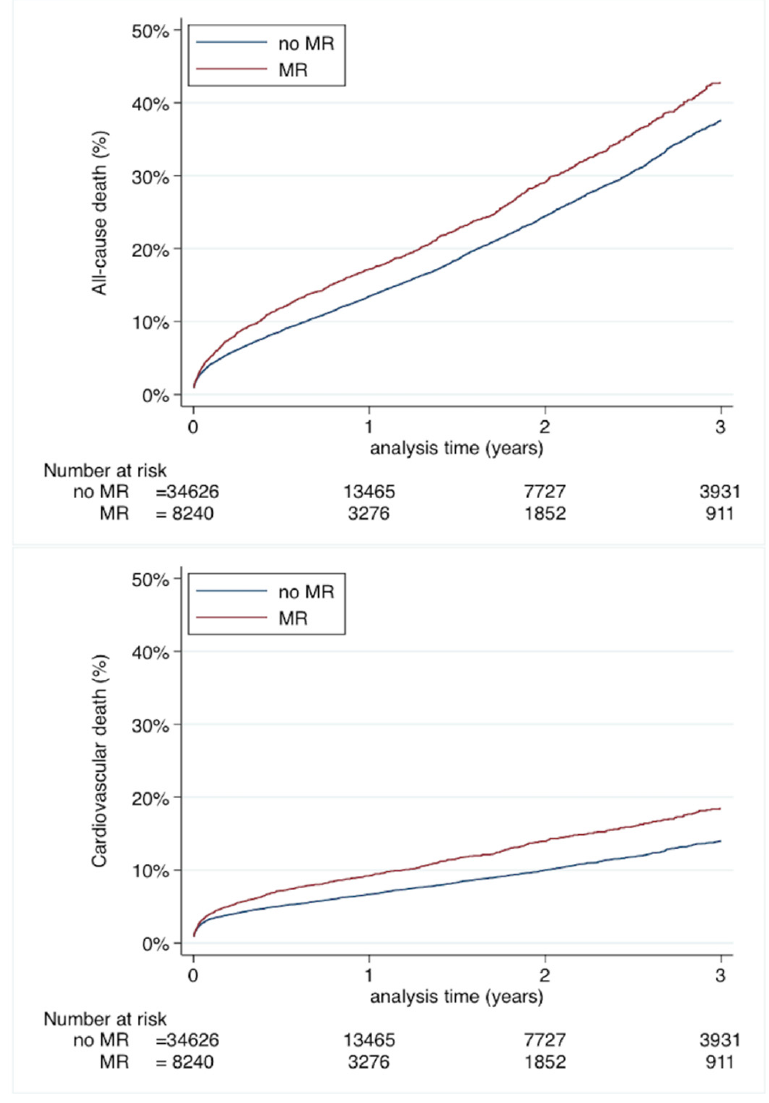
Figure 2. Cumulative incidence for all-cause mortality (top panel) and cardiovascular mortality (lower panel) of patients treated with TAVI with MR or no MR at baseline.